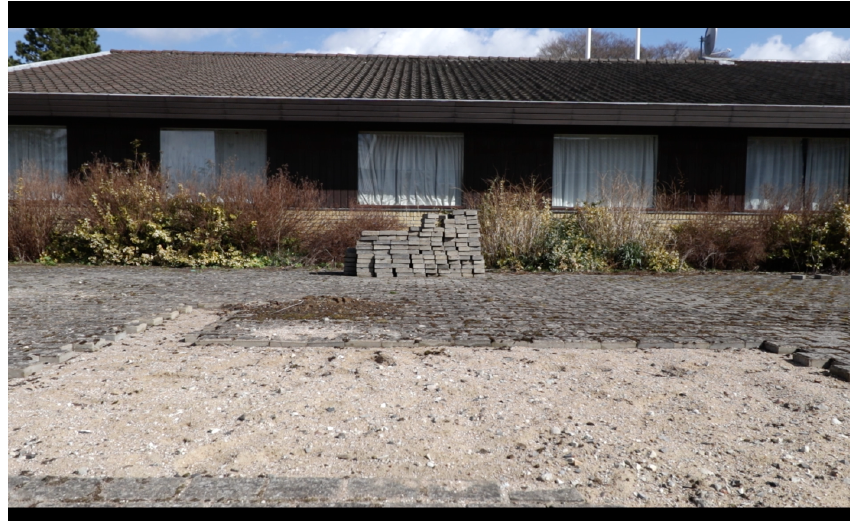
Figure 5. Bricks have been collected and stacked in the yard. March